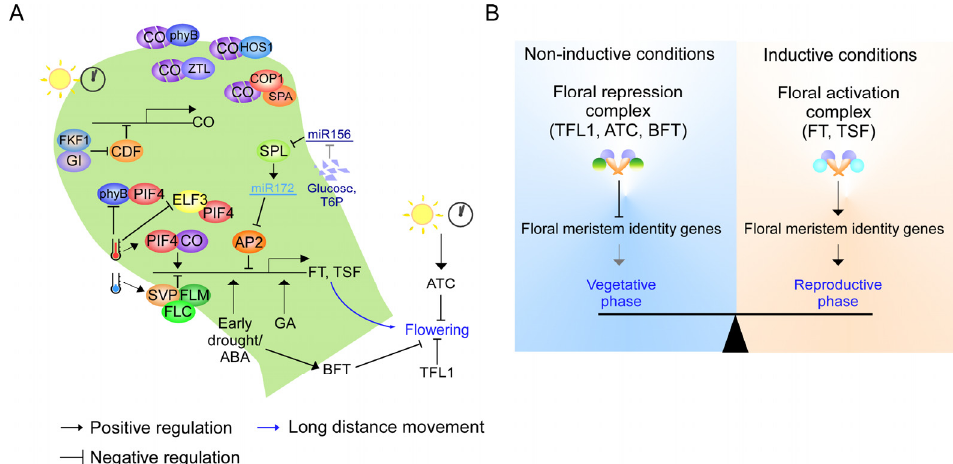
Figure 2. Schematic representation of PEBP signaling network in flowering time regulation of Arabidopsis. ( A ) Schematic representation of flowering time regulation in Arabidopsis by PEBP. Internal and external cues regulate the expression and activity of PEBP to fine-tune floral development. LD conditions, warm temperatures, early drought, ABA, GA, and sugars represent positive signals to promote floral initiation. In contrast, SD conditions and cool temperatures represent negative seasonal cues that delay floral formation. ( B ) Classification of Arabidopsis PEBP as a floral activator or floral repressor. Under noninductive conditions, FD and 14-3-3 primarily form a floral repression complex with anti-florigen, TFL1, ATC, and BFT to repress the expression of floral meristem identity genes. However, under inductive conditions, high levels of florigen, FT, and TSF compete with anti-florigen to make a floral activation complex that activates floral meristem identity genes.